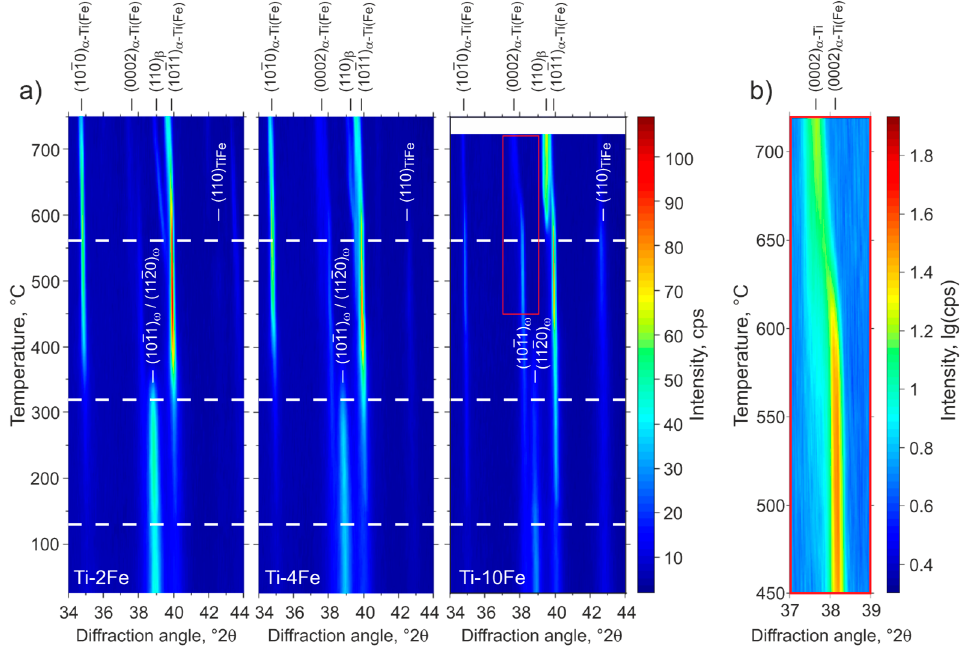
Figure 4. DSC heating curves of alloys Ti-2Fe, Ti-4Fe, and Ti-10Fe measured with the heating rate of 10 K/min. The dashed lines at 130 °C and 320 °C indicate the beginning and the end of the ω back-transformation as concluded from high-temperature X-ray diffraction (HTXRD). The dashed line at 562 °C marks the eutectoid reaction β -(Ti,Fe) ⇌ α -Ti(Fe) + TiFe. The temperatures marked by crosses indicate the β -transus temperatures (solvus temperatures of the β phase), which were determined as inflection points of the respective DSC curves.